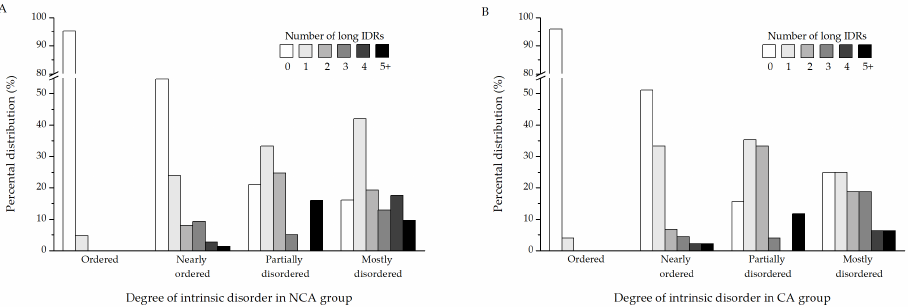
Figure 4. Distribution of long intrinsically disordered regions in proteins with various degrees of intrinsic disorder in the ( A ) NCA (non-cold-acclimated diapausing) and ( B ) CA (cold-acclimated diapausing) experimental groups. The different numbers of long IDRs in proteins are color-coded.